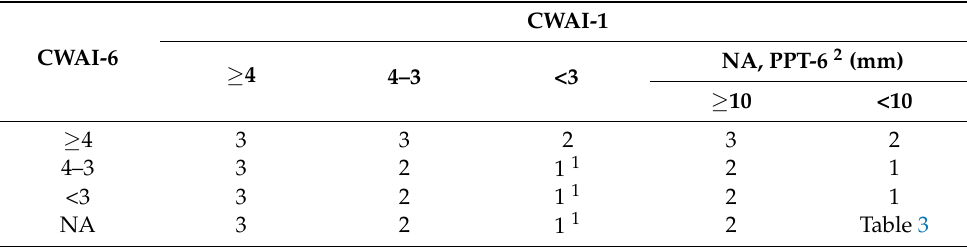
Table 2. Decision matrix for alert level determination for cases where values of CWAI-1 and/or CWAI-6 are available.